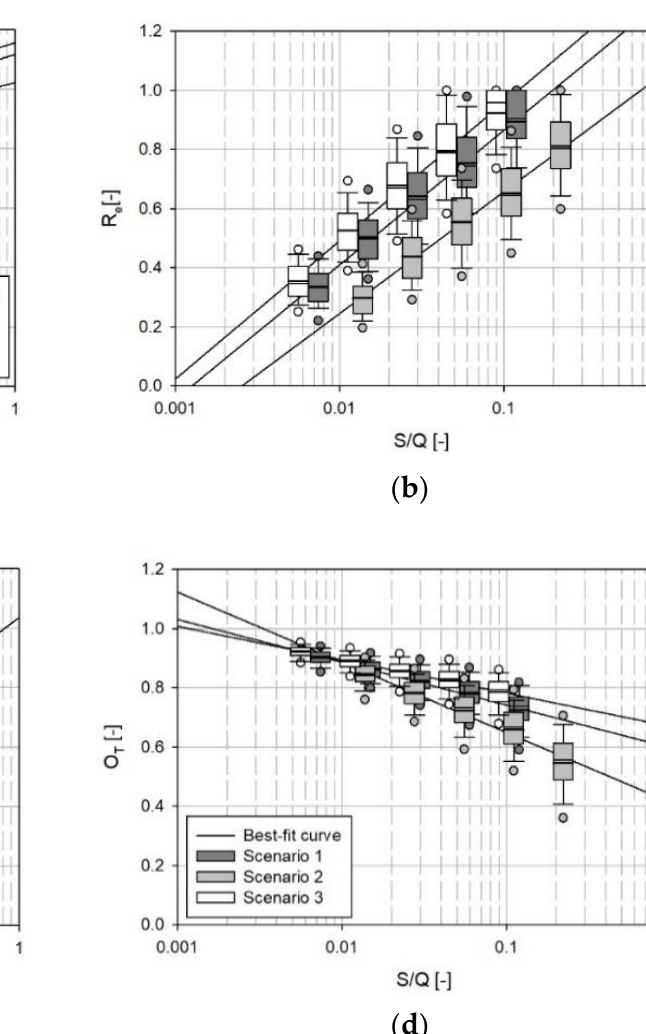
calculated from the mean values of the investigated indices.